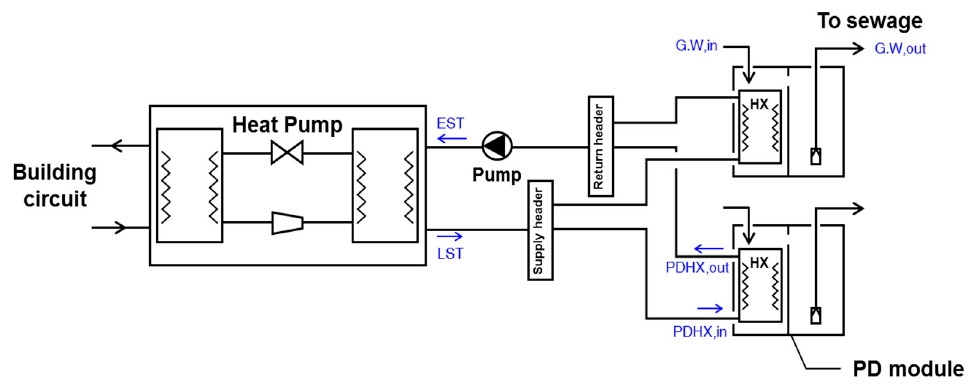
6 of 17 Table 3. Measured groundwater inflow rates for eight apartment sites. Site